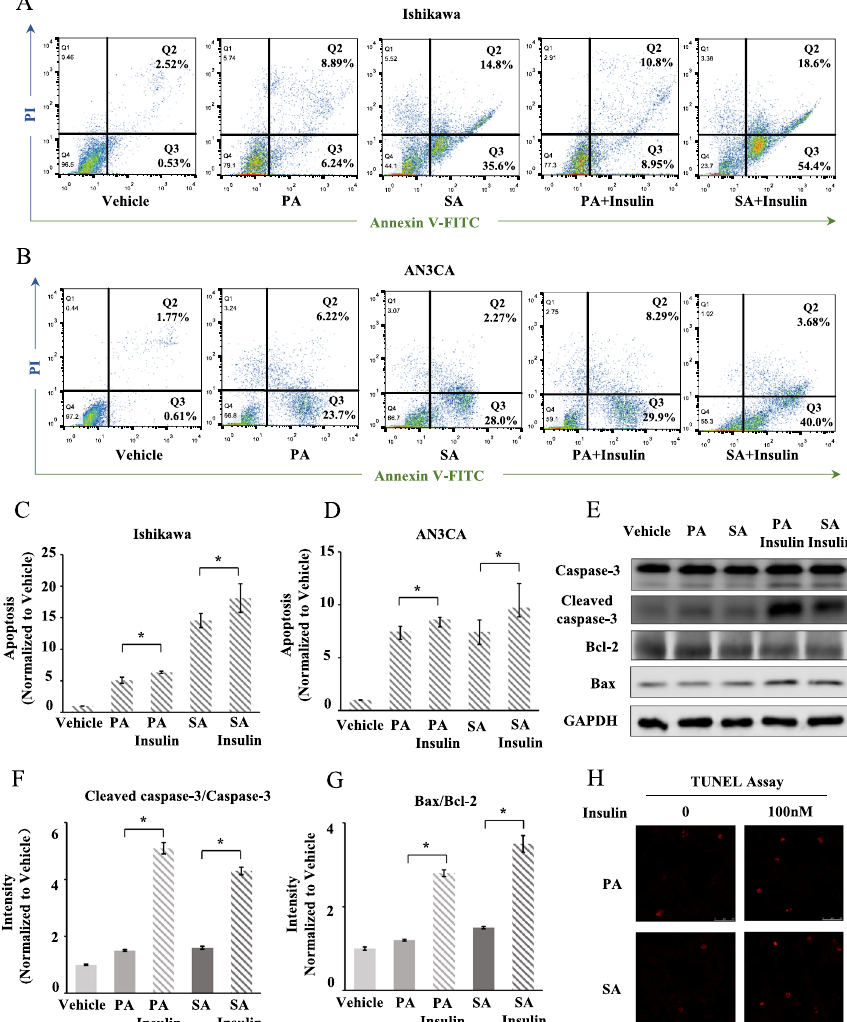
Fig. 3 High insulin level accelerates palmitic acid-induced apoptosis in endometrial cancer cells. A , B Apoptosis of Ishikawa and AN3CA cells detecting by Annexin V-FITC/PI labelling flow cytometry after saturated fatty acid and/or insulin treatment. The proportion of apoptotic cells was detected after treatment with 0.5 mM palmitic acid (PA) or 0.5 mM stearic acid (SA) for 12 h in Ishikawa cells and treatment for 18 h in AN3CA cells. The proportion of apoptotic cells were also compared after treatment with 0.5 mM PA alone or 0.5 mM PA plus 100 nM insulin, 0.5 mM SA alone or 0.5 mM SA plus 100 nM insulin. Saturated fatty acid (PA and SA) significantly induced apoptosis in EC cells, and the pro-apoptotic effect could be enhanced by excessive insulin. C , D Analysis of Annexin-V-positive cell ratio * P < 0.05. E – G Immunoblot of caspase-3, cleaved caspase-3, Bcl-2, Bax and GAPDH after saturated fatty acid and/or insulin treatment. Ishikawa cells are treated with 0.5 mM PA or 0.5 mM SA alone, and PA or SA plus 100 mM insulin for 12 h. Histogram plot shows cleaved caspase-3/caspase-3 and Bax/Bcl-2 intensity relative to vehicle * P < 0.05. H Apoptotic effect of insulin on PA or SA-treated (0.5 mM) Ishikawa cells, determined by TUNEL assay